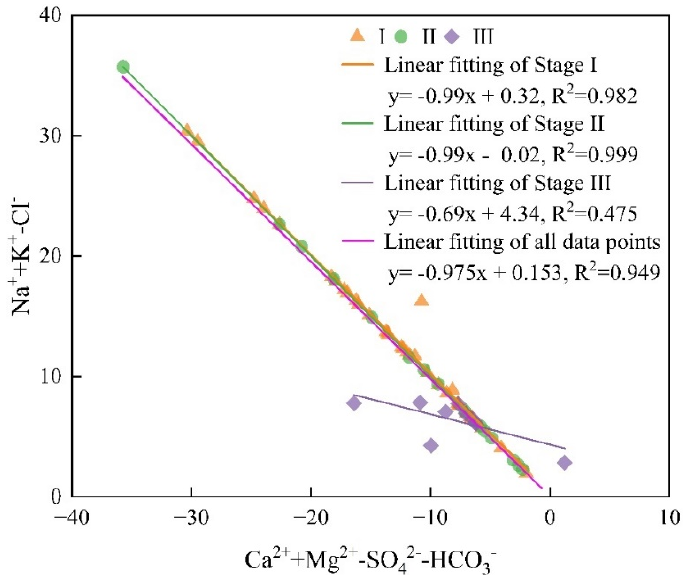
Figure 12. Bivariate diagram of conventional components of karst groundwater in Taiyuan Formation.